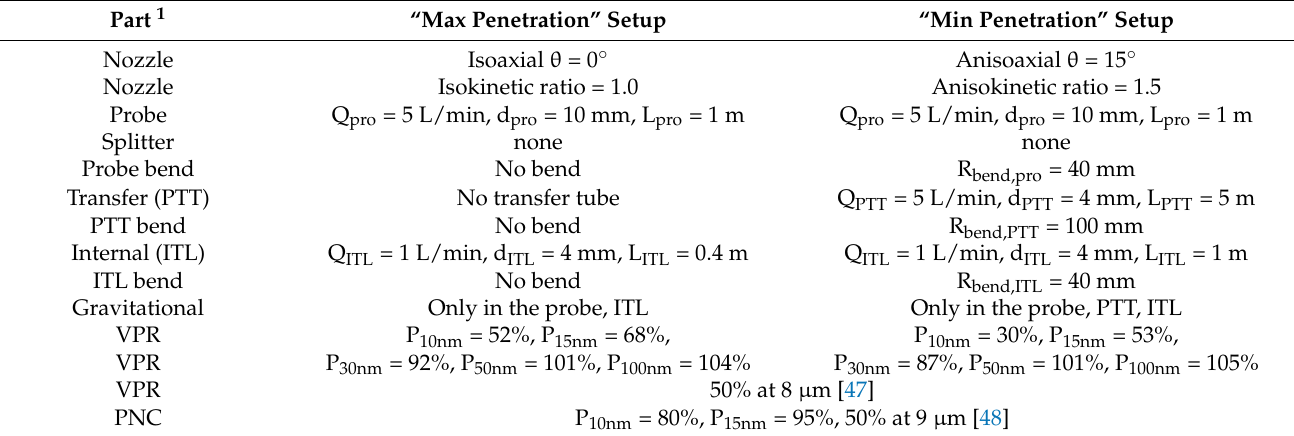
Table 1. Assumed parameters for the estimation of particle losses for the two